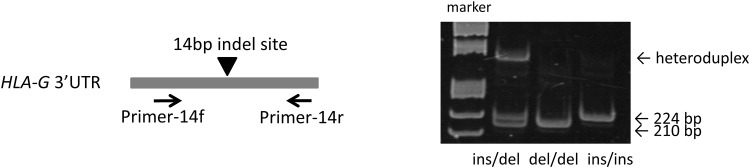
Genotyping for HLA-G 14 indel polymorphism.(Left) Primers were placed to encompass the 14bp indel site between primers. (Right) Polyacrylamide gel electrophoresis of the PCR products. The upper band in the ins/del lane shows the heteroduplex product formed by the ins and del allele products, which takes altered conformation and shows retardation in electrophoretic mobility. Ins, insertion; del, non-insertion.